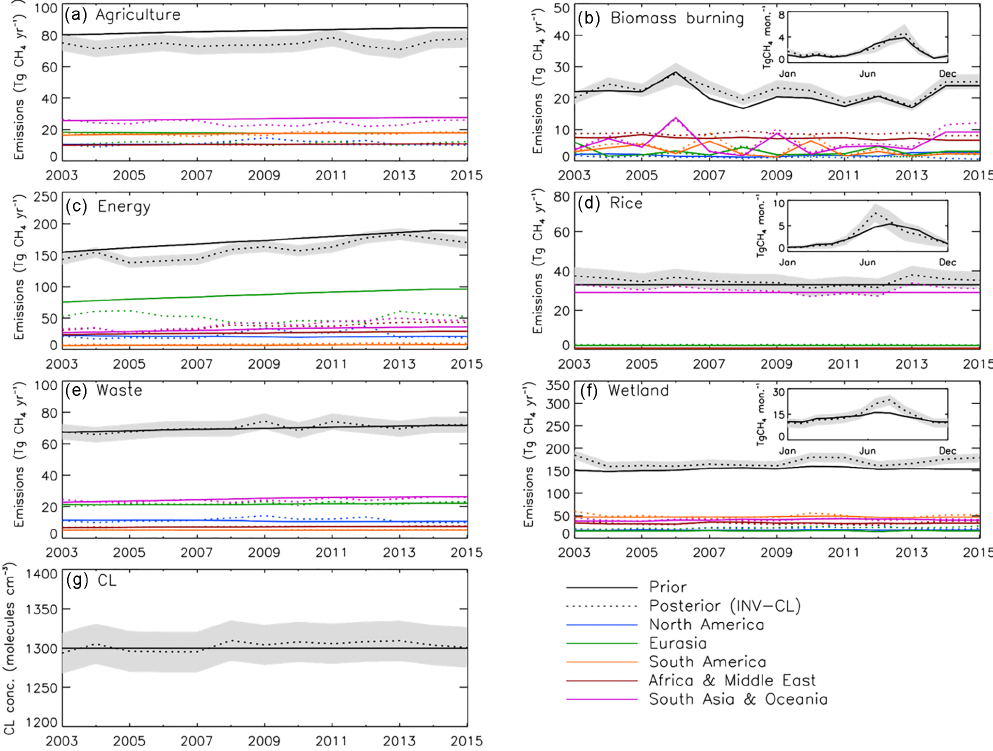
Figure 10. (a–f) Annual CH 4 emissions (TgCH 4 yr − 1 ) from different sectors for global prior (black solid line) and INV-CL (black dotted line) estimates. Regional estimates are also displayed for North America (blue), Eurasia (green), South America (orange), Africa and the Middle East (red), and South Asia and Oceania (purple). (g) Prior and posterior global tropospheric Cl estimates for the same period. Shaded region denotes posterior error A (see Eq. 5 in